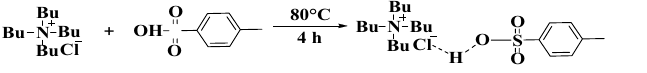
Figure 1. The preparation of TBAC/